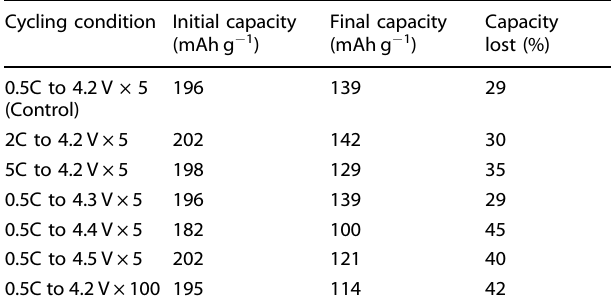
Fig. 4 Electrochemical data for cycled coin cells. Electrochemical data: a cell charging capacity (mAh g − 1 ) for each sample at each cycle, b capacity loss as a percentage of fi rst charge, and c capacity loss as a percentage of second Table 3. Electrochemical data for initial and fi nal capacities and the overall lost percentage.